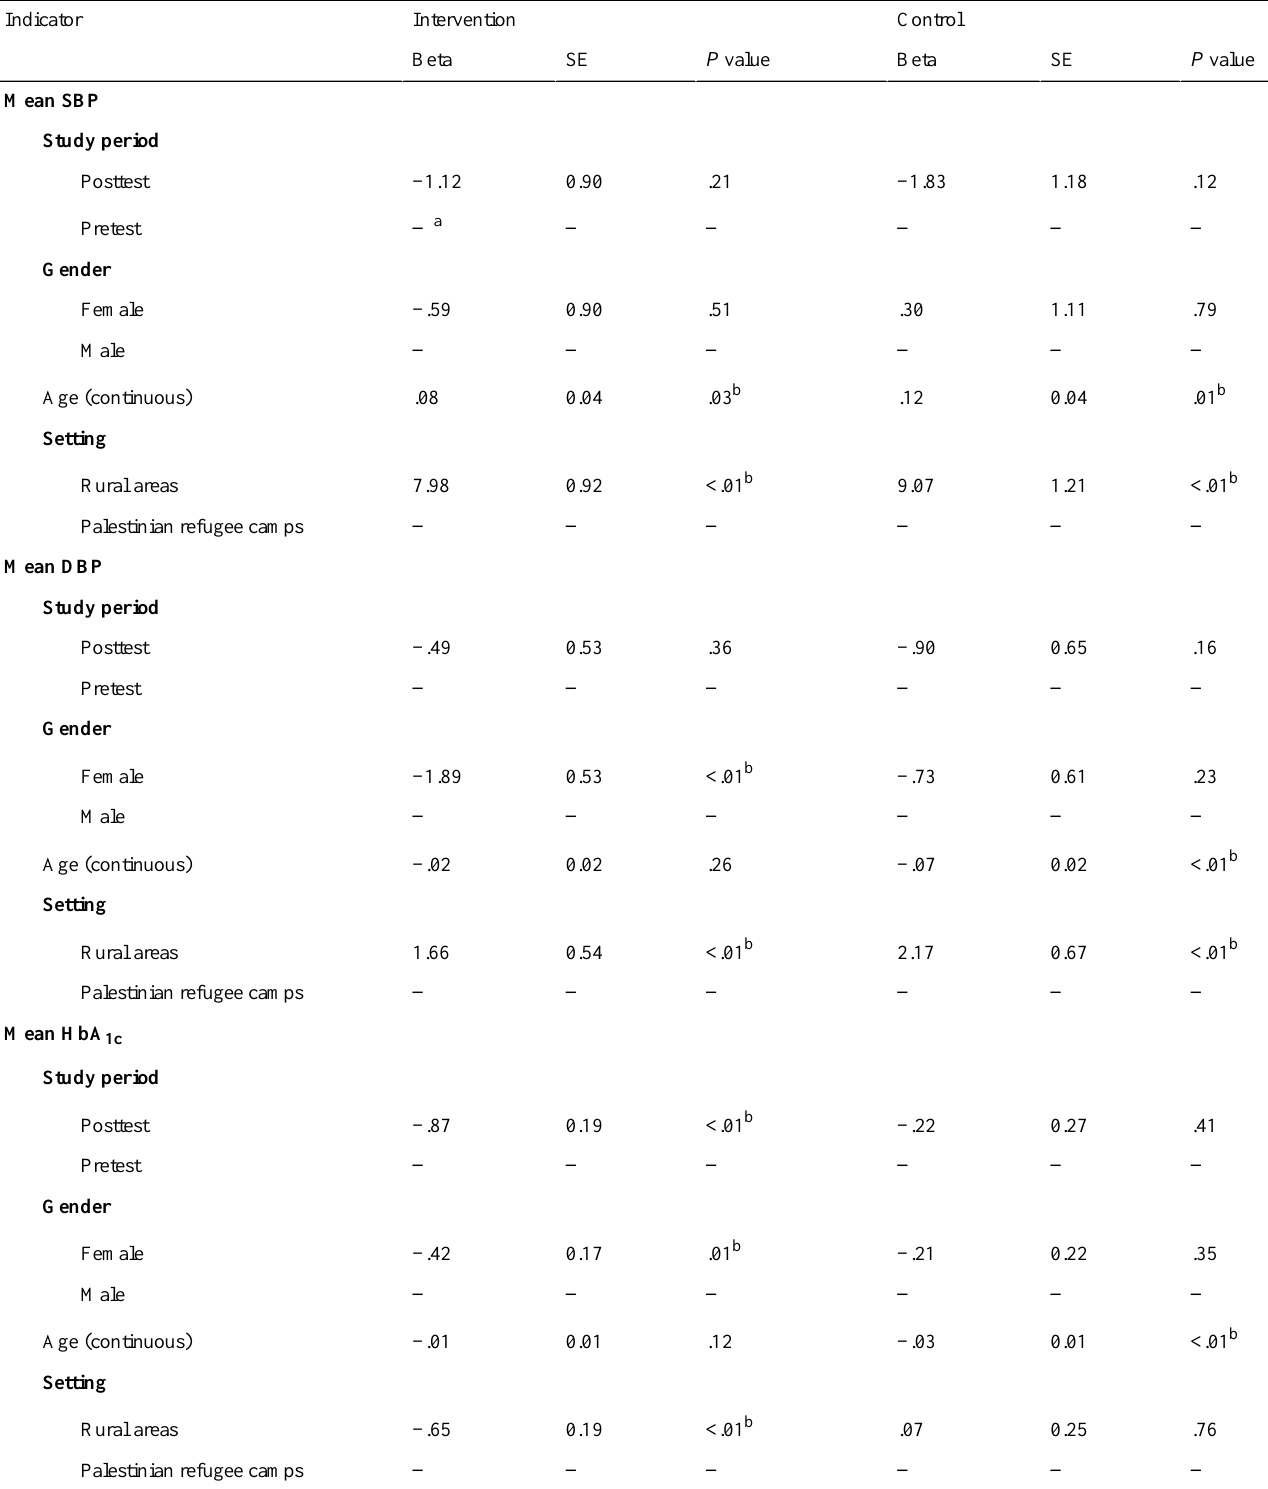
Table 5. Linear regression model of the means systolic blood pressure (SBP), diastolic blood pressure (DBP), and glycated hemoglobin (HbA 1c ) by study group.